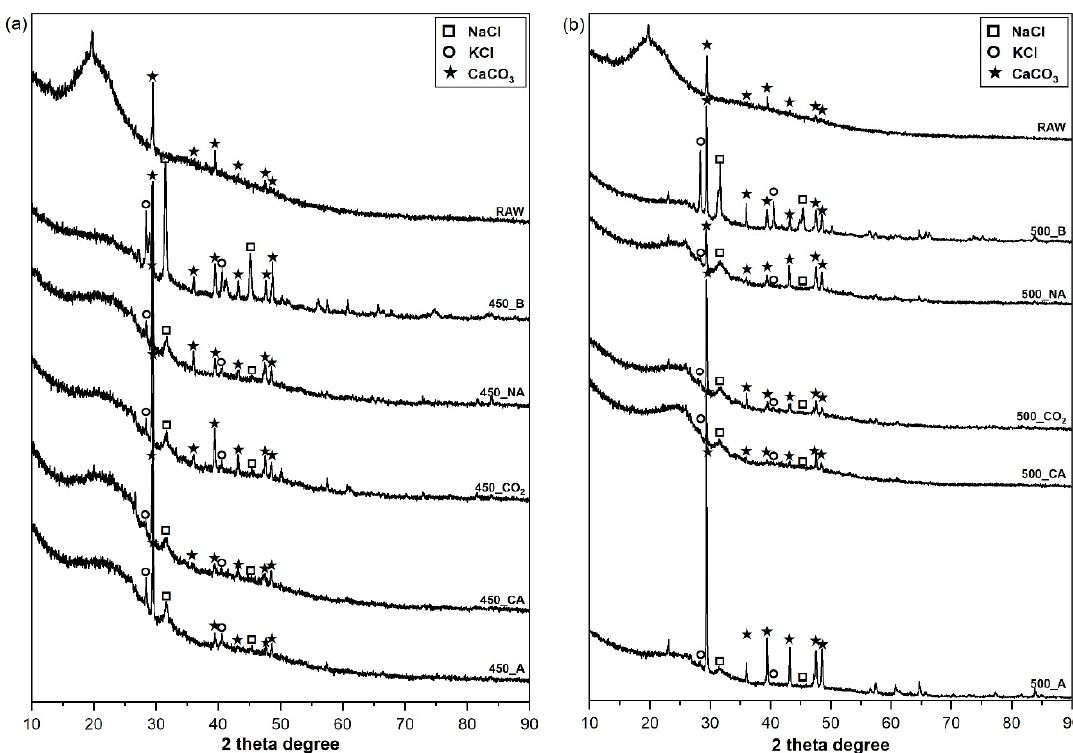
Figure 4. X-ray diffraction (XRD) patterns of biochar pyrolyzed at 450 °C ( a ) and 500 °C ( b ).